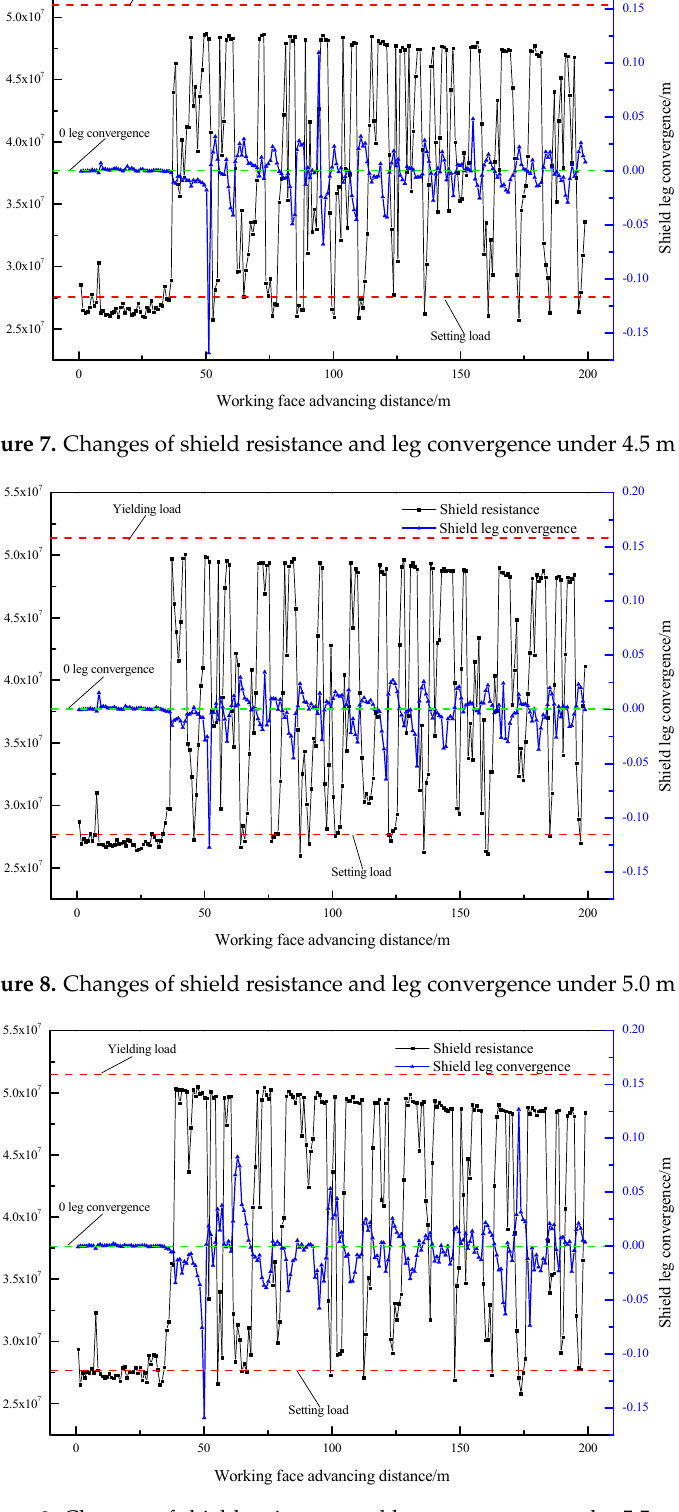
Figure 9. Changes of shield resistance and leg convergence under 5.5 m mining height. 3.2.3. Large Mining Height Simulation Data Analysis At 6.0 m mining height, the maximum shield resistance reached the yield load 52.8 MPa, the average resistance of the shield was 40.8 MPa, and the single maximum shrink- age of the shield column was 113.0 mm. The first weighting interval of the basic roof was 37.2 m, the periodic weighting interval of the basic roof was 10.5–11.0 m, and the average periodic weighting interval was about 10.5 m, as shown in Figure 10.